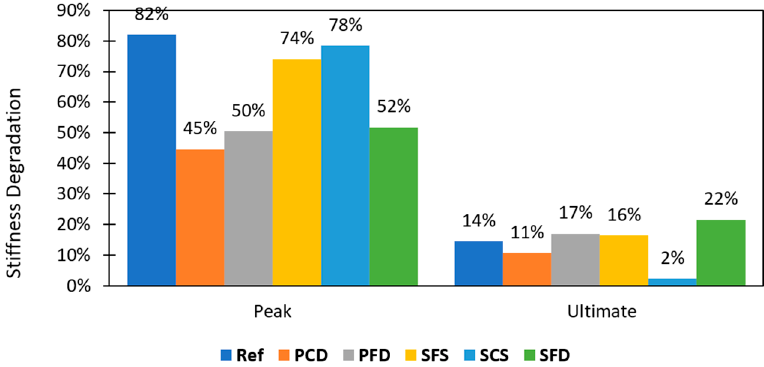
Figure 18. Stiffness degradation.